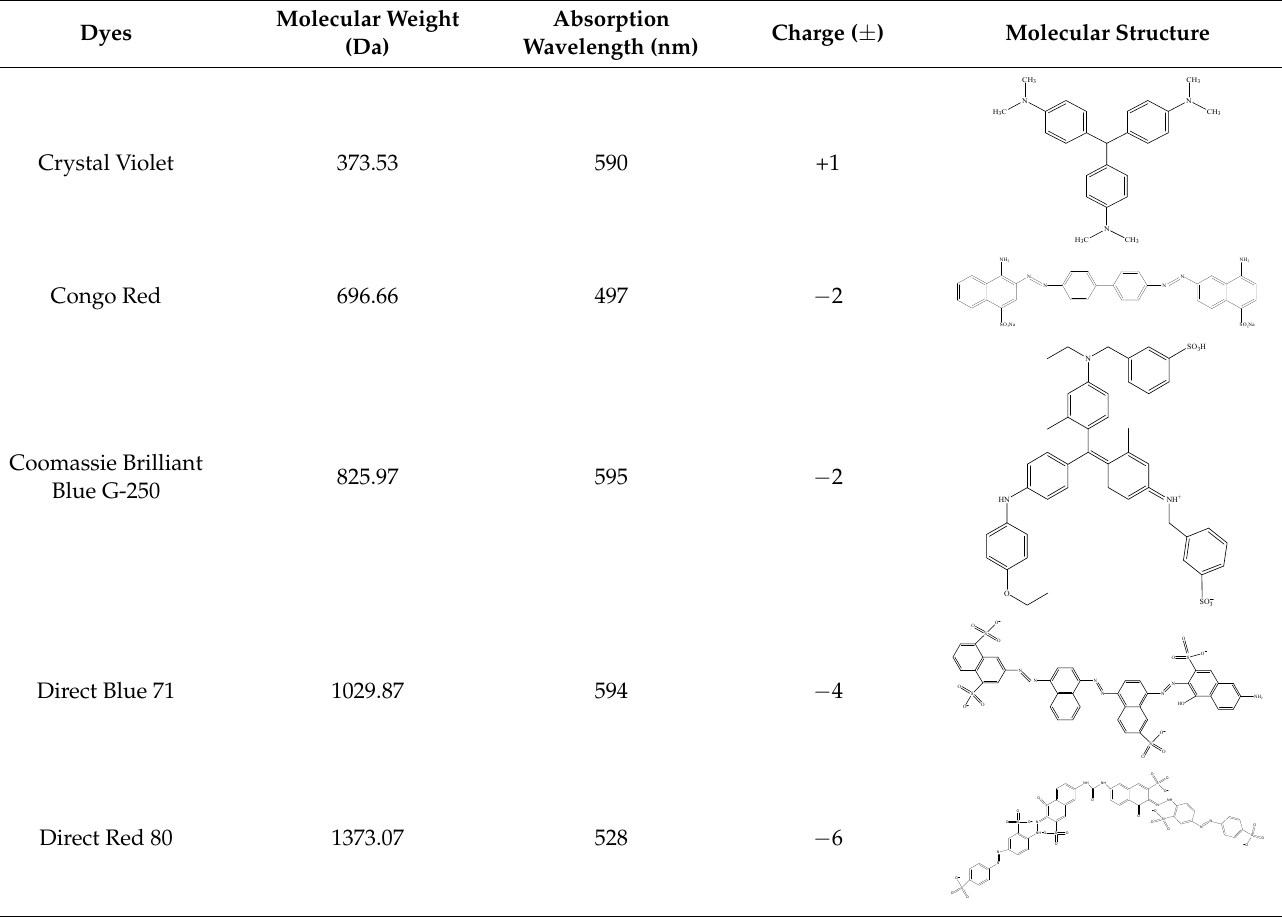
Table 1. Characteristics of the tested dyes.